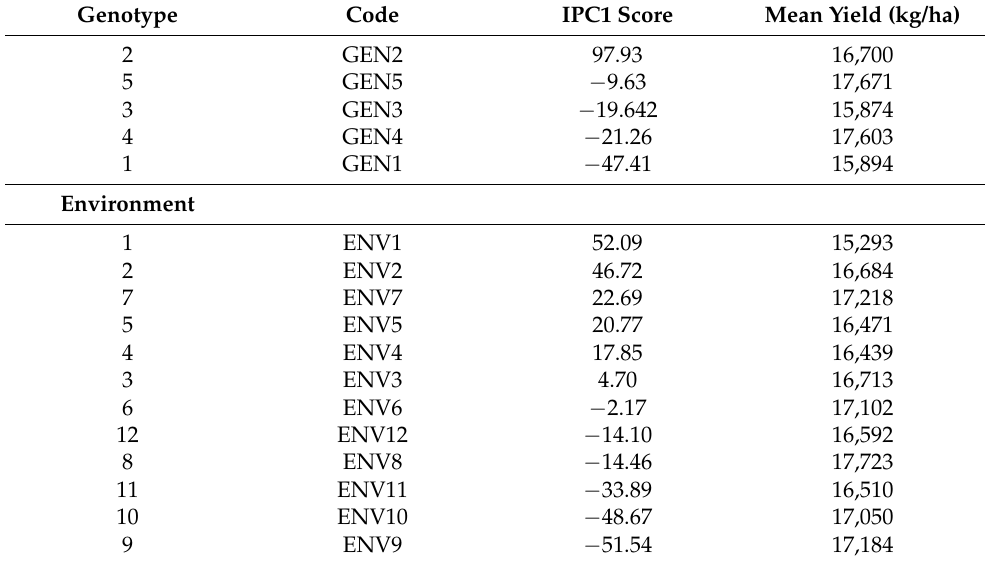
Table 6. Ranking of the genotypes and the environments according to their IPC1 scores for grain